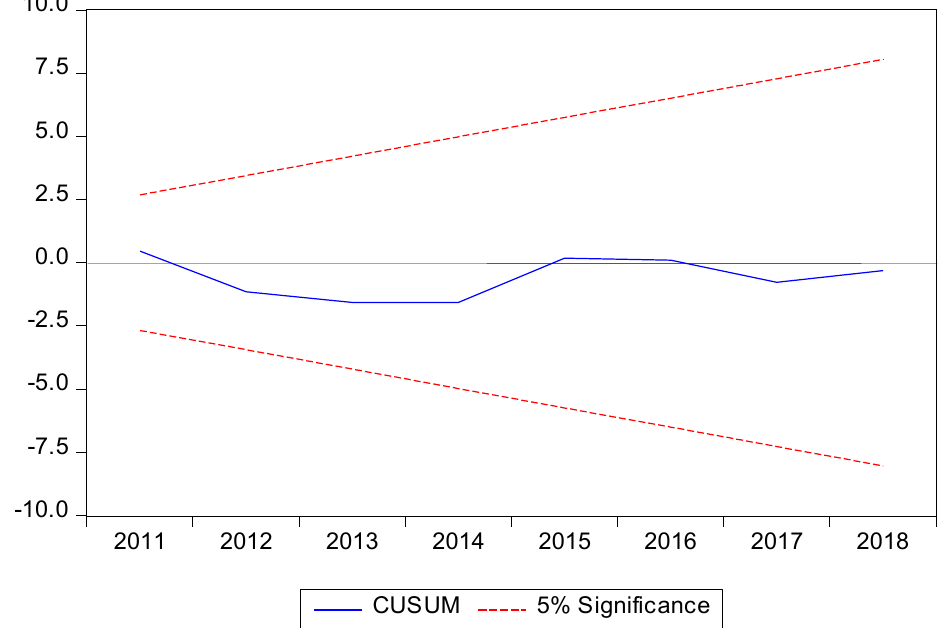
Figure 1: Plots of the Cumulative Sum (CUSUM) of Recursive Residuals